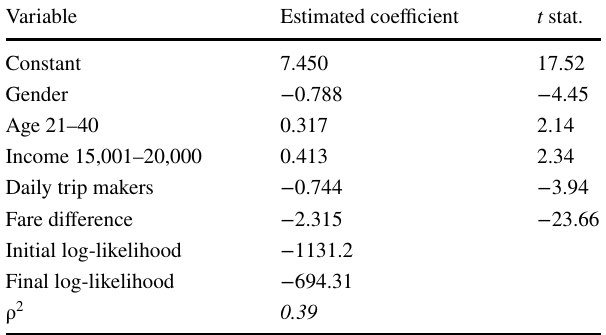
Table 8 Recalibrated model (using 1632 data points)